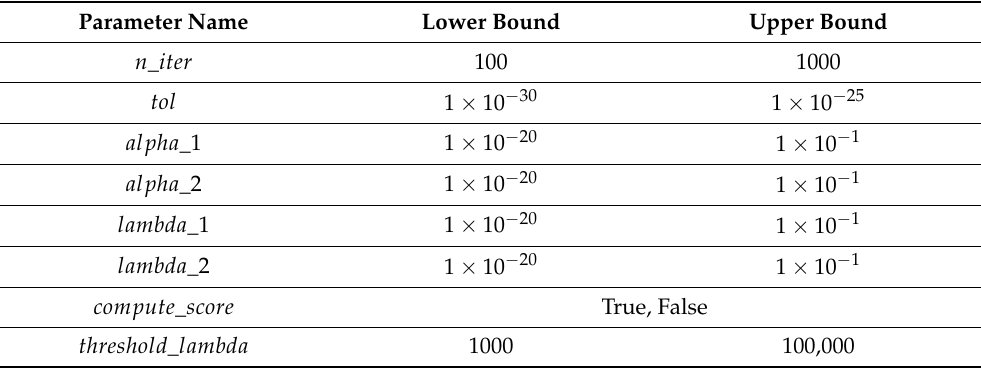
Table 3. An overview of the used hyper-parameter range for ARD regression